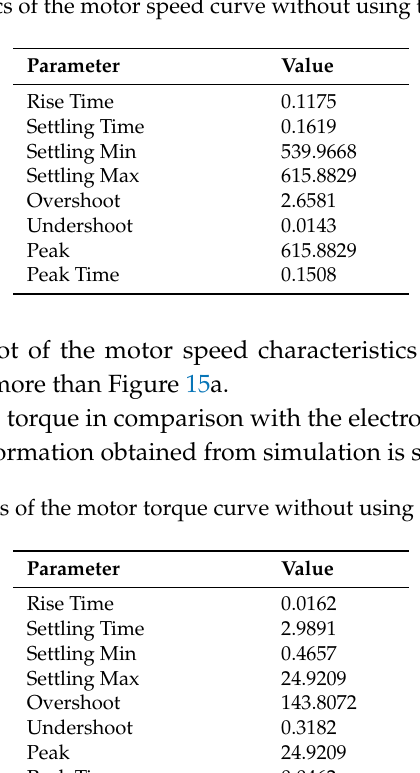
Table 5. Characteristics of the motor speed curve without using the correction method.